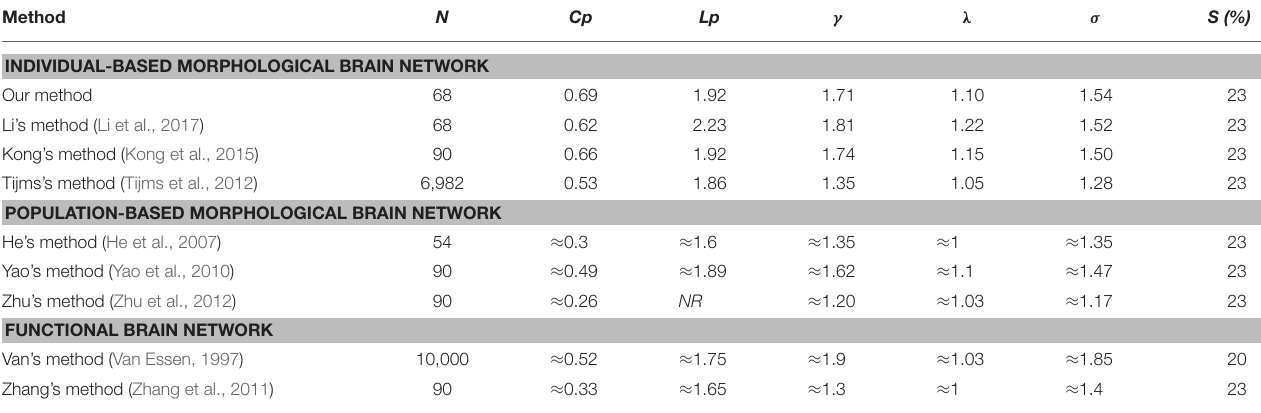
TABLE 2 | Comparison of small world configurations between the present study and previous